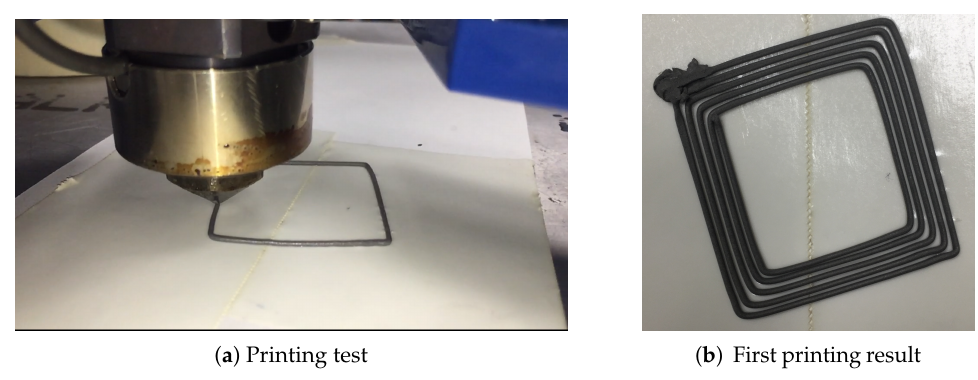
Figure 17. First deposition